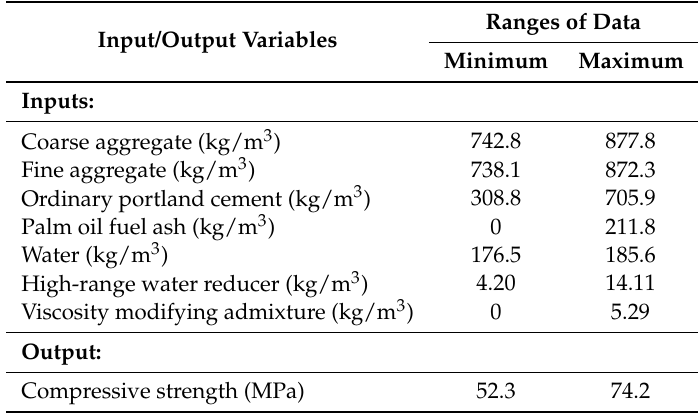
Figure 2. Final architecture of the ANN model. Table 4. Input and output variables used in the ANN model.